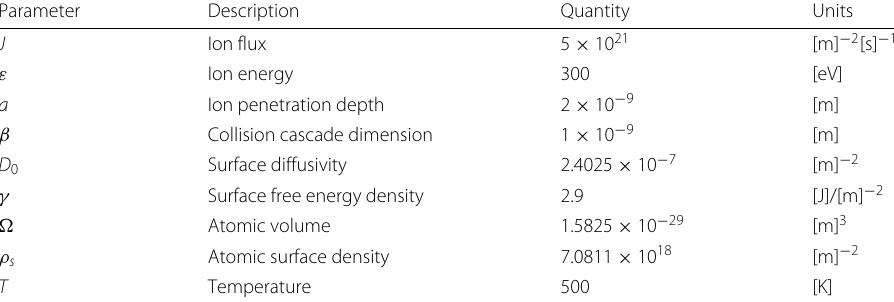
Table 1 Parameters used to define the surface evolution Parameter